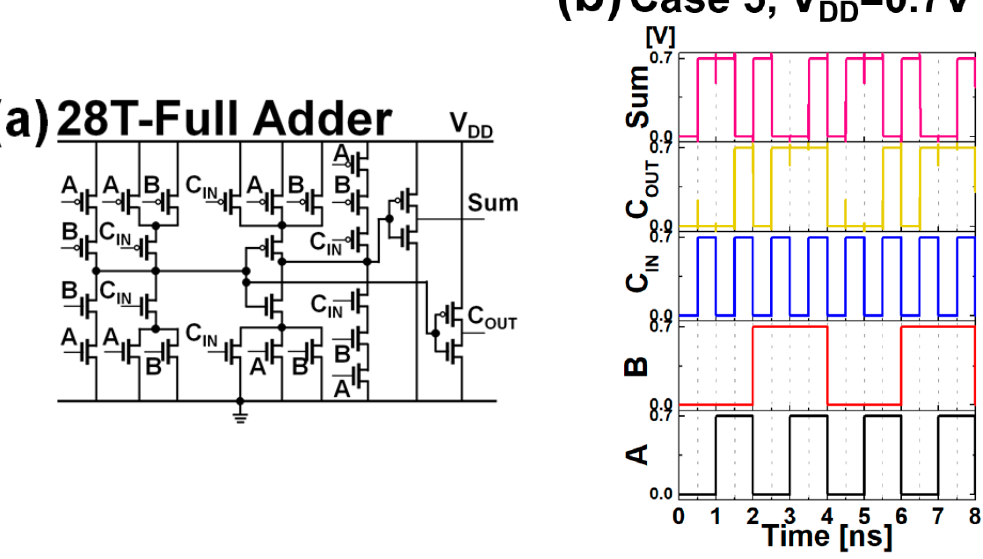
Figure 10. ( a ) Conventional 28T-FA schematic, ( b ) input/output versus time for case 5 when the V DD is 0.7 V. Table 2. Performance comparison of mNS-FET